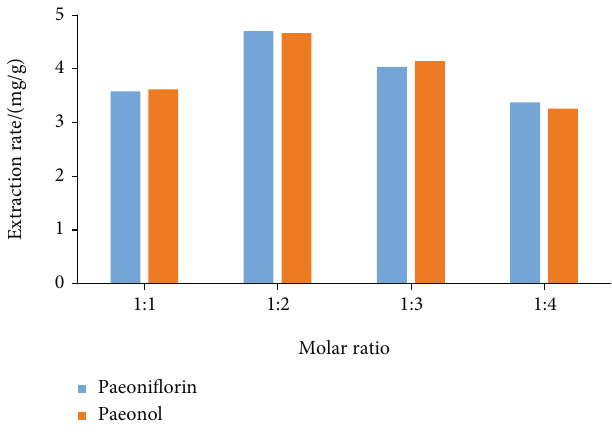
Figure 2: E ff ect of molar ratio on Moutan Cortex extraction e ffi ciency.